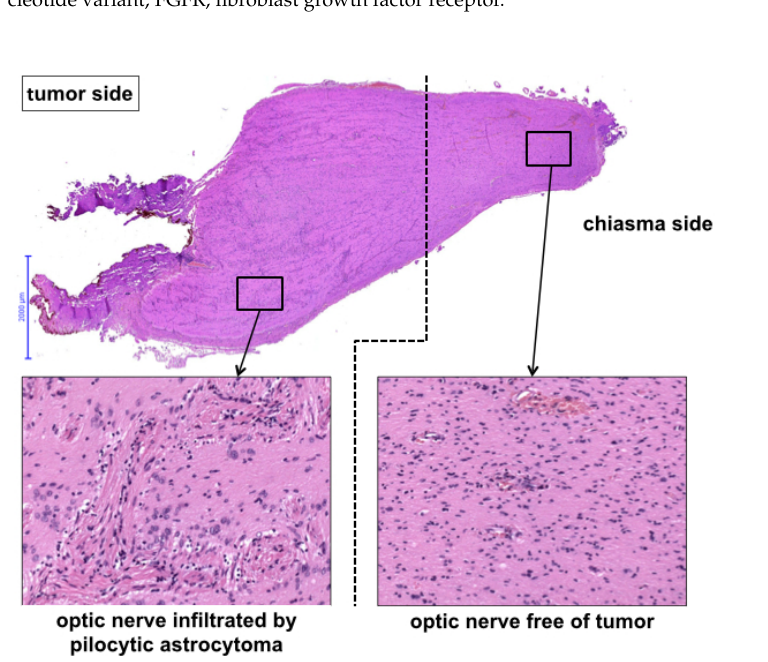
with this type of tumor manifestation. All tumors except one case clustered to methylation class low ‐ grade glioma, including subclassification midline pilocytic astrocytoma in four cases. One case clustered into the basket group low tumor content/reactive tissue.